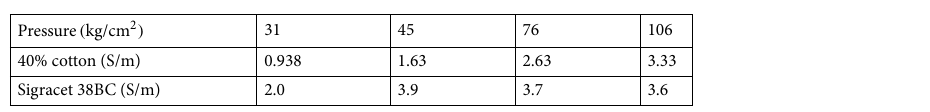
Table 2. Through-plane electrical conductivity as a function of pressure for the GDL with 40% cotton fiber and Sigracet 38BC.